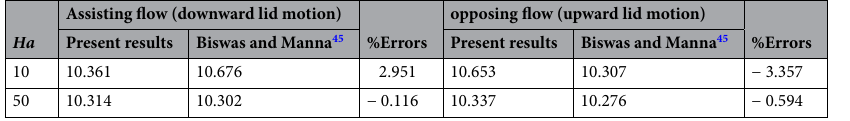
Table 3. Comparison of the average Nusselt Number for the different values Hartmann number Ha .